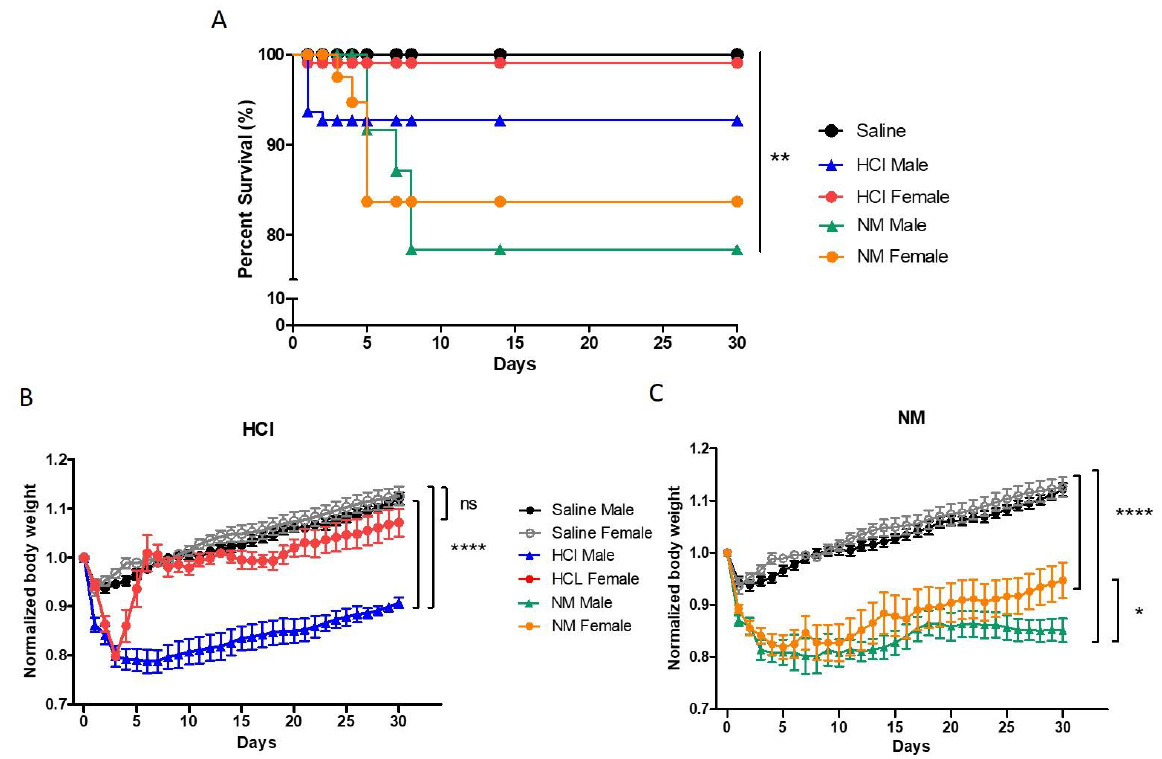
Figure 1. ( A ) Kaplan–Meyer survival curves after NM or HCl exposure in female and male mice (** p < 0.01) with log-rank (Mantel–Cox) test, n ≥ 25. ( B ) HCl provoked a significant decrease in body weight (20%) in both males and females at 48 h after instillation. Female animals recovered quickly and started gaining weight similarly to saline treated animals (ns: p > 0.05) while male mice maintained a reduced body weight different from either saline or females (**** p < 0.0001). One-way ANOVA with the Bonferroni post-test; n ≥ 6. ( C ) NM provoked a significant decrease in body weight (~20%) in both males and females at 48h after instillation, compared to corresponding saline-treated animals (**** p < 0.0001). From day 23 on, females began gaining weight at a faster rate than males (* p < 0.05). Normalized body weight data were obtained by dividing body weight of each animal by its day 0 (day of instillation) body weight. One-way ANOVA with the Bonferroni post-test; n ≥ 6.